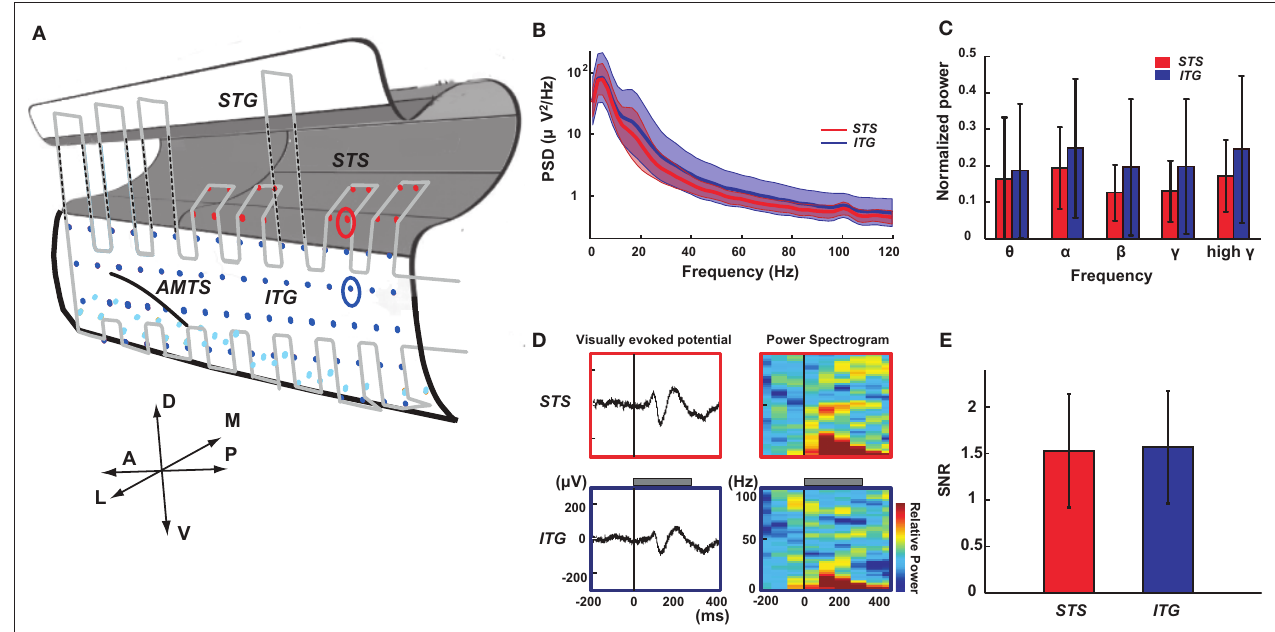
FigurE 5 | Electrocorticography recording from STS and iTg. (A) Schematic drawing of the left temporal lobe with the electrode array. Dots indicate contacts of the ECoG array covering the STS (red), the lateral part of ITG (blue) and the ventral part of ITG (light blue). Light gray line indicates the outer of the probe. The red and blue circles denote the contact in STS and ITG shown in (D) . A, anterior; P, posterior; D, dorsal; V, ventral; L, lateral; M, medial; AMTS , anterior middle temporal sulcus. (B) Power spectral density (PSD) of ECoG signals from the STS (red) and ITG (blue) during the intertrial interval of a visual fixation task. Solid lines and colored areas indicate mean and standard deviation of PSD, respectively. Data from all the STS ( n = 16) and ITG ( n = 82) electrodes in one monkey are included. (C) Normalized power of ECoG signals from STS ( n = 34)